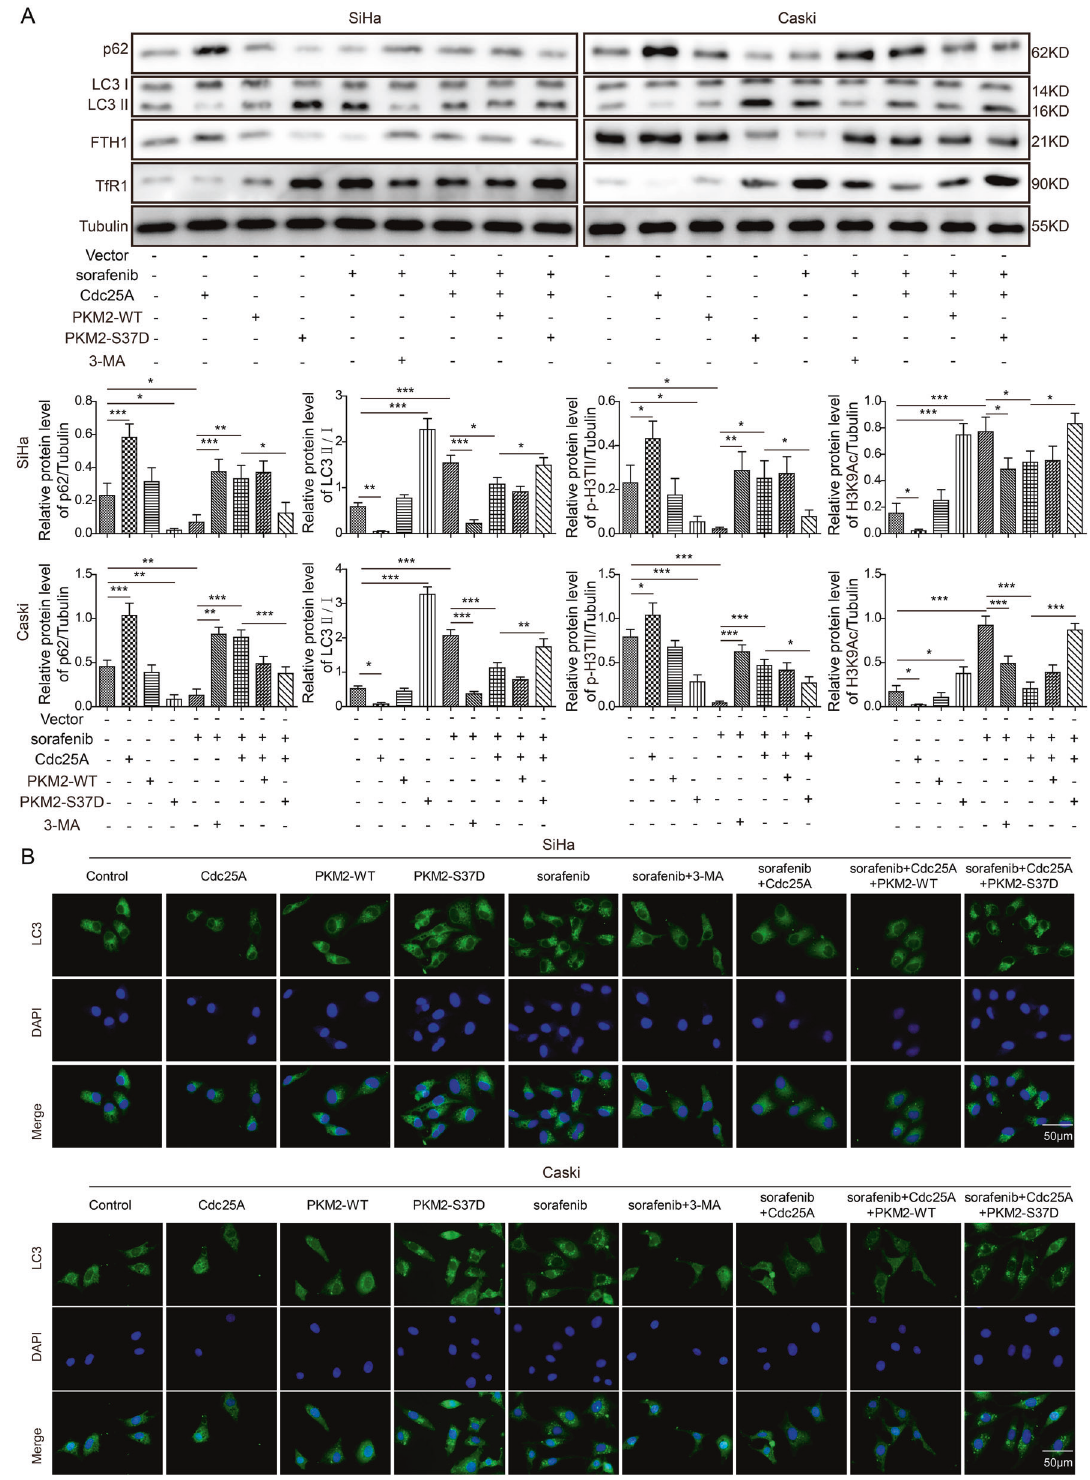
Fig. 5 Cdc25A inhibited autophagy to suppress sorafenib-induced ferroptosis. A Relative protein levels of p62, LC3-I, LC3-II, FTH1, and TfR1 in transfected cells with or without sorafenib treatment. B Relative GFP-LC3 signalling in transfected cells with or without sorafenib treatment. Each experiment was repeated three times. * P < 0.05; ** P < LC3-II/LC3-I ratio (Fig. 7A, B). Co-transfection of sh-ErbB2 blocked these Cdc25A-mediated changes in sorafenib-treated cells (Fig. 7A, B). In addition, Cdc25A decreased the GFP-LC3 signal in sorafenib-treated cells, while co-transfection of sh-ErbB2